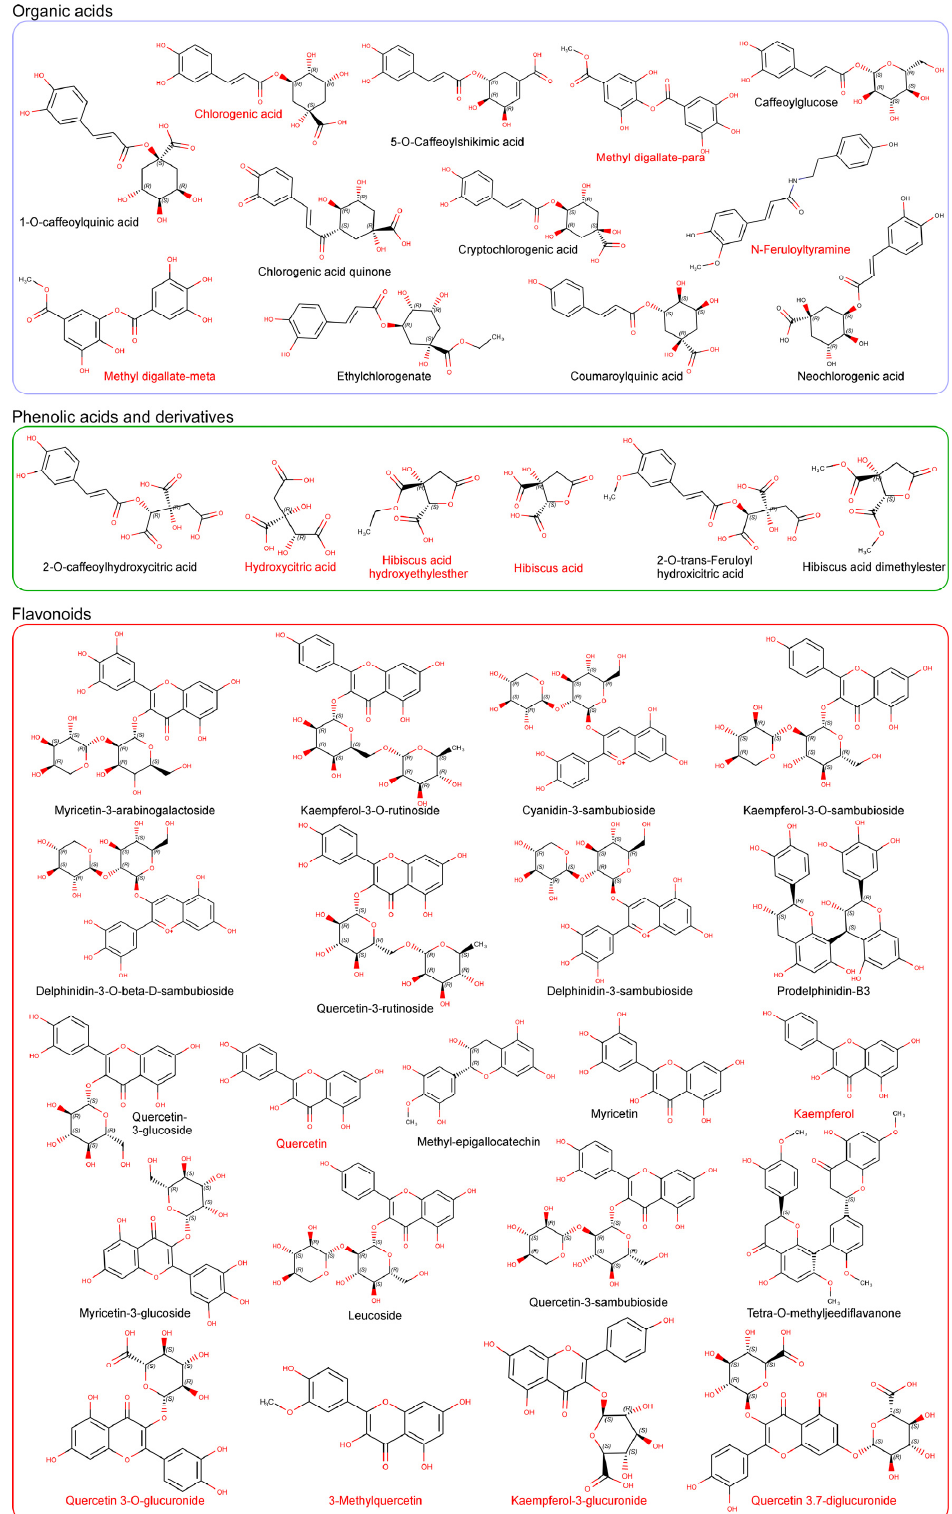
Figure 1. Chemical structures (explicit hydrogens have been eliminated) of the major compounds identified in Hibiscus sabdariffa extracts by liquid chromatography coupled to high resolution mass spectrometry. Compounds are grouped in families according to their chemical structure. The complete characterization of the extracts has been previously reported [18,20,37]. The common name of each compound is included under its structure. Compounds with their names in red indicate that these compounds have been identified as plasma metabolites in the